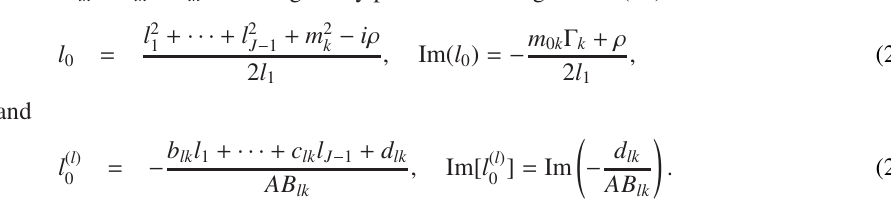
with AB lk = a lk − b lk . The singularity poles of the integrand in (21) are